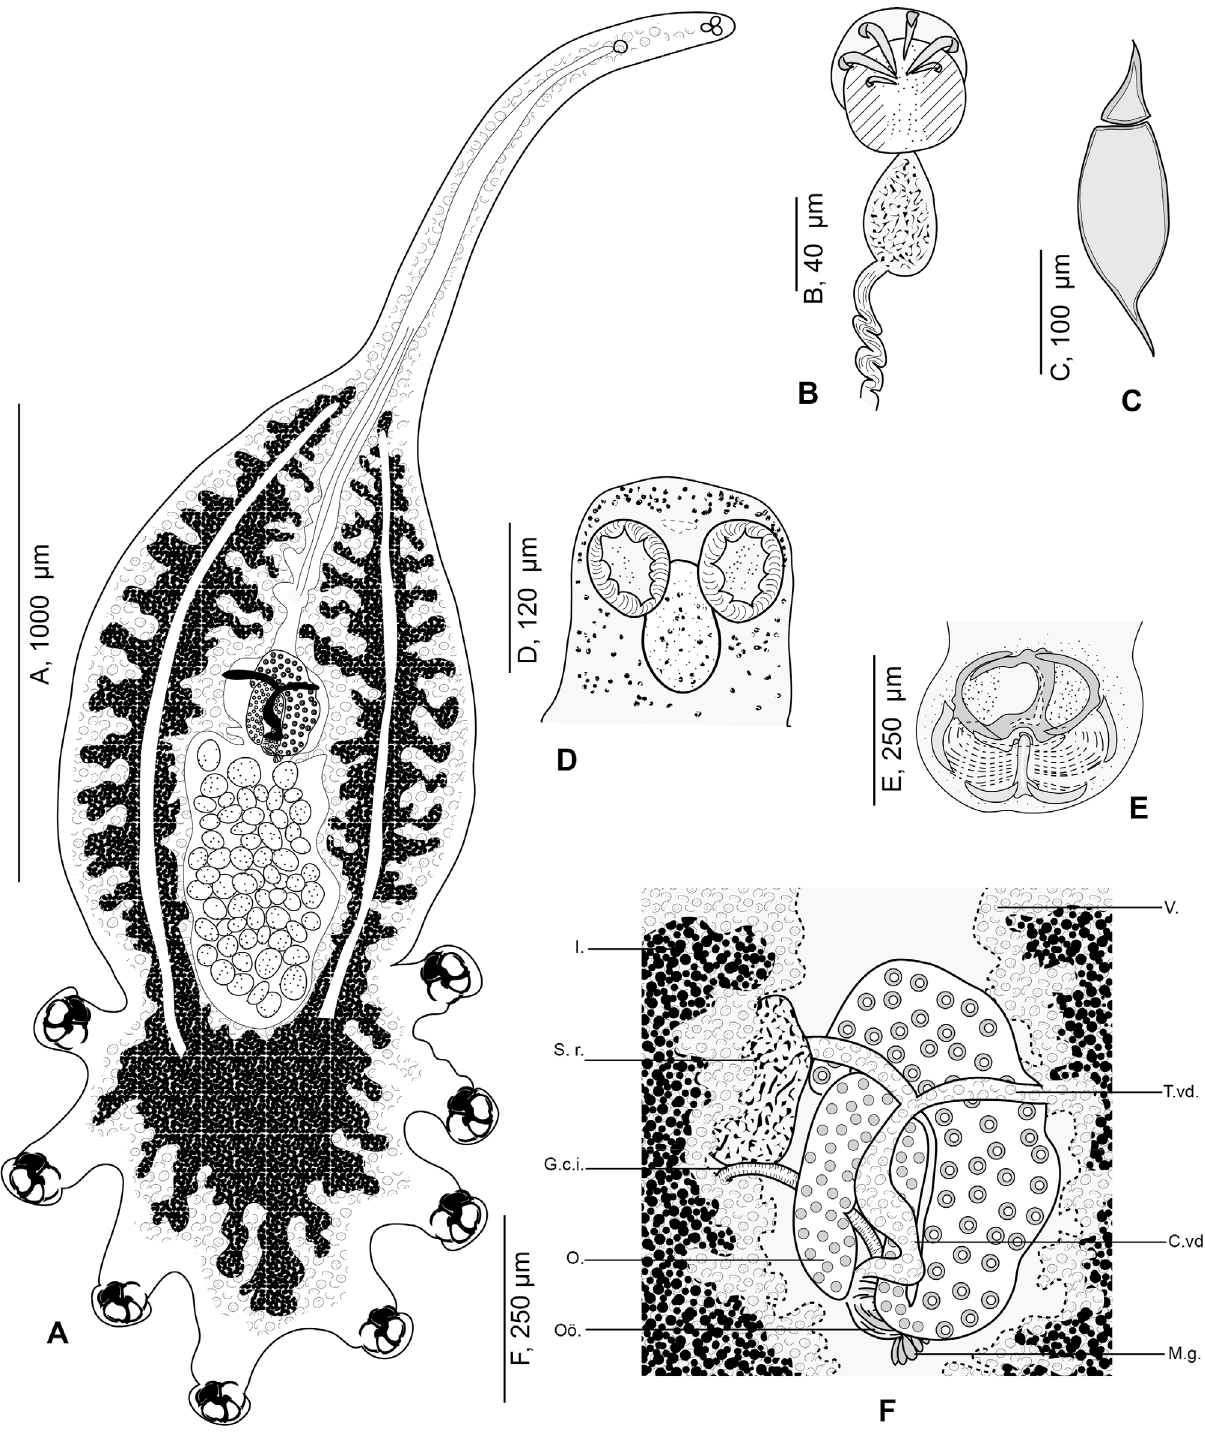
Figure 2. Cyclocotyla bellones Otto, 1823, specimen from Ceratothoa parallela from Boops boops , Algeria. A, whole body, MNHN HEL1312 (reproduced from Bouguerche et al., 2021 [15]); B, male copulatory organ, MNHN HEL1313; C, egg, MNHN HEL1314; D, anterior part, MNHN HEL1313; E, clamp, MNHN HEL1316; F, anatomy at level of ovarian zone, MNHN HEL1315. V., vitellarium. T.vd., transverse vitelloduct. C.vd., common vitelloduct. M.g., Mehlis ’ glands. I., intestine. S.v., seminal vesicle. G.c.i., genito-intestinal canal. O., ovary. Oö.,